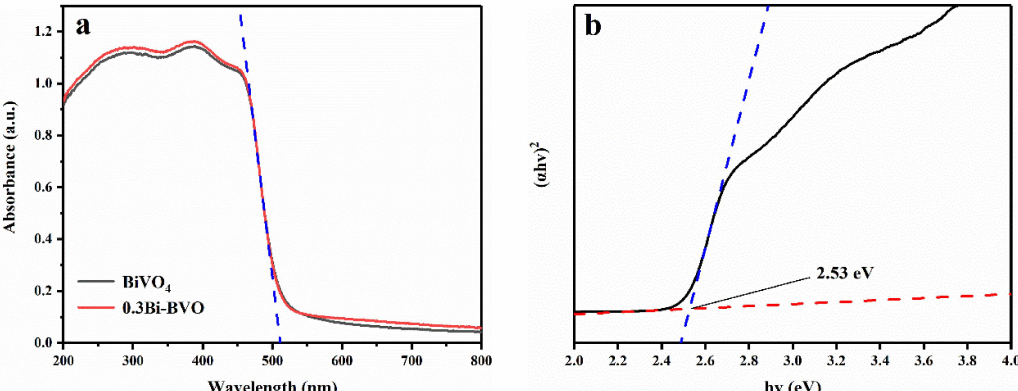
Figure 4. ( a ) UV-vis DRS of BiVO 4 and 0.3Bi-BiVO and ( b ) plots of ( α hv) 2 versus hv for BiVO 4 .